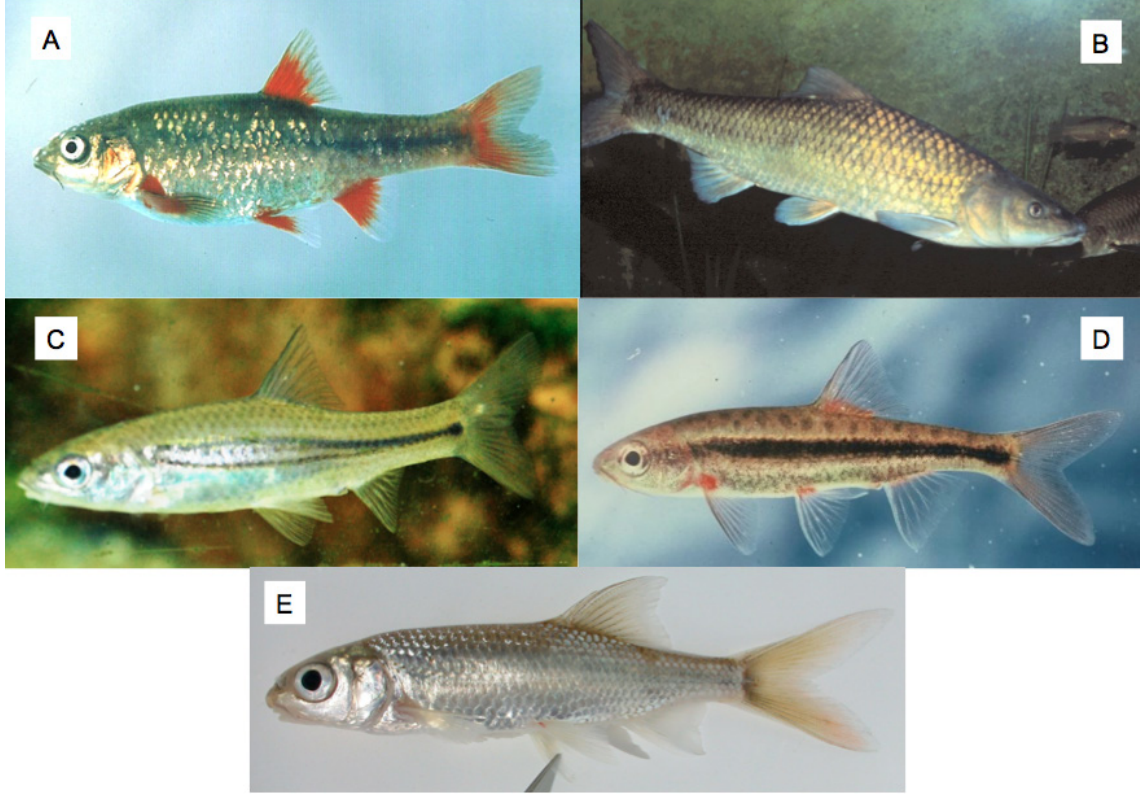
Fig. 10. Species representative of southern African tetraploid cyprinine genera. A . Pseudobarbus afer (Peters, 1864). B . Cheilobarbus capensis Smith, 1841 . C . Amatolacypris trevelyani (Günther, 1877) gen. et comb. nov . D . Sedercypris calidus (Barnard, 1938) gen. et comb. nov . E . Namaquacypris hospes (Barnard, 1938) gen. et comb. nov . Photograph credits: A–D by P.H. Skelton (SAIAB); E by R.I. Bills